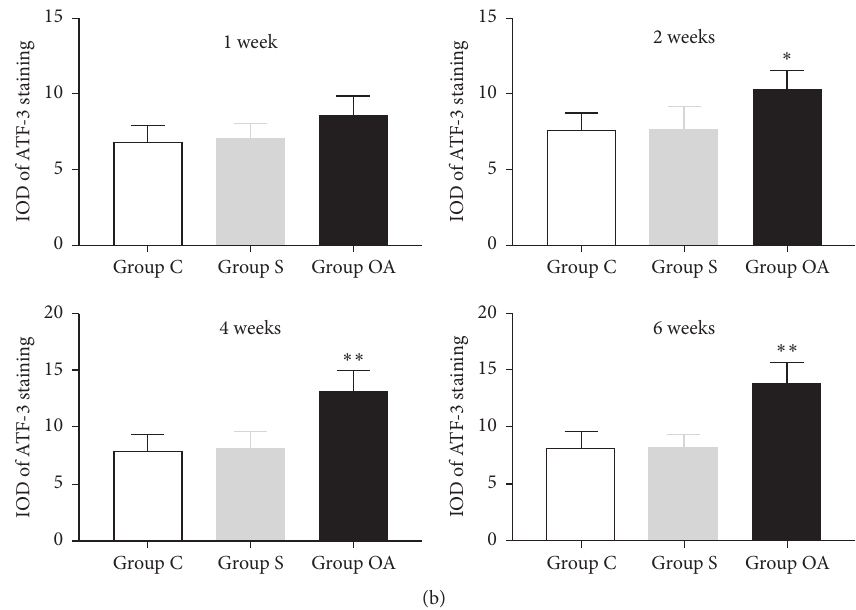
Figure 3: Comparison of ATF-3 expression in the three groups of rats at each time point. (a) Double immunofluorescence staining of ATF-3 in the DRGs. (b) Analysis of integrated optical density (IOD) of ATF-3. Each symbol represents mean ± SD (standard deviation), n � 4 per group; ∗ P < 0 . 05, ∗∗ P < 0 . 01 vs. group C. One-way ANOVA and LSD test.